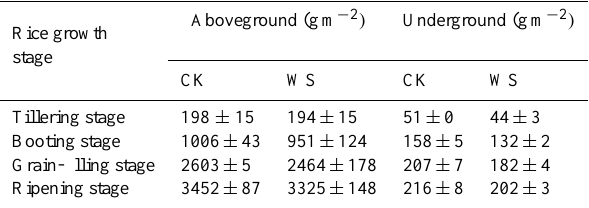
Table 2. δ 13 C-values of CH 4 (‰) emitted before and after cutting of the plants. WS: straw incorporation, CK: without straw incorpo- ration.